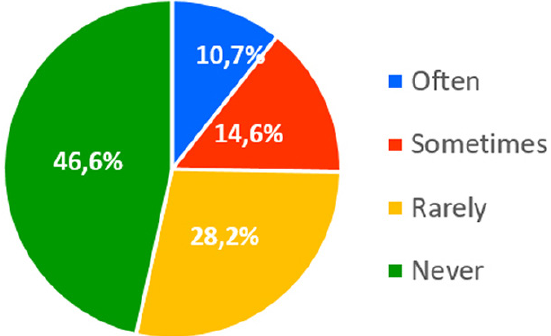
Fig. 11. Percentage of students who have had laboratory practice in secondary